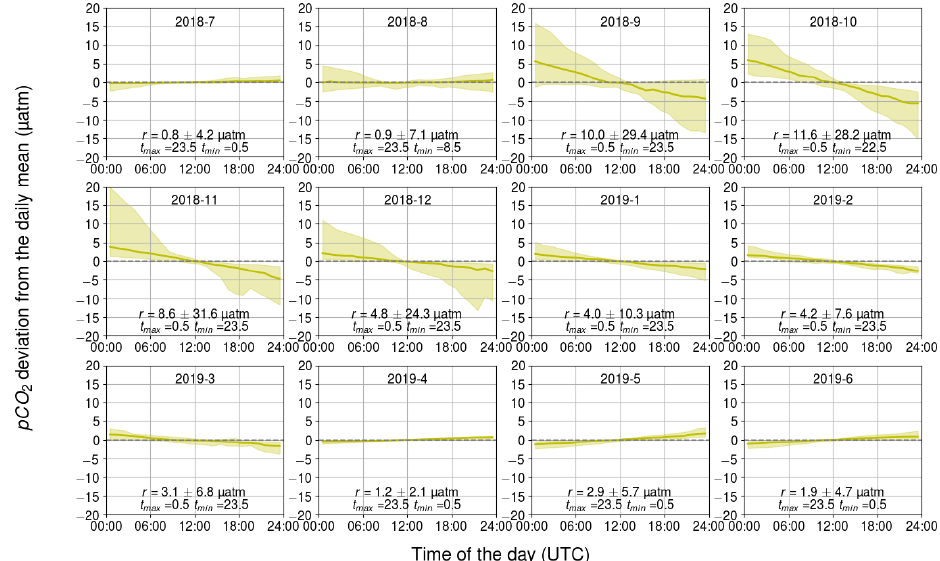
Figure 8. Monthly p CO 2 diurnal variability generated by the air–sea exchange of carbon dioxide, showing the binned median and difference of the minimum of the 10th percentile and the maximum of the 90th percentile. The y axis shows the p CO 2 deviation (in µatm) and the x axis shows the hour of the day. Range, r , and the time for the maximum and minimum p CO 2 are also